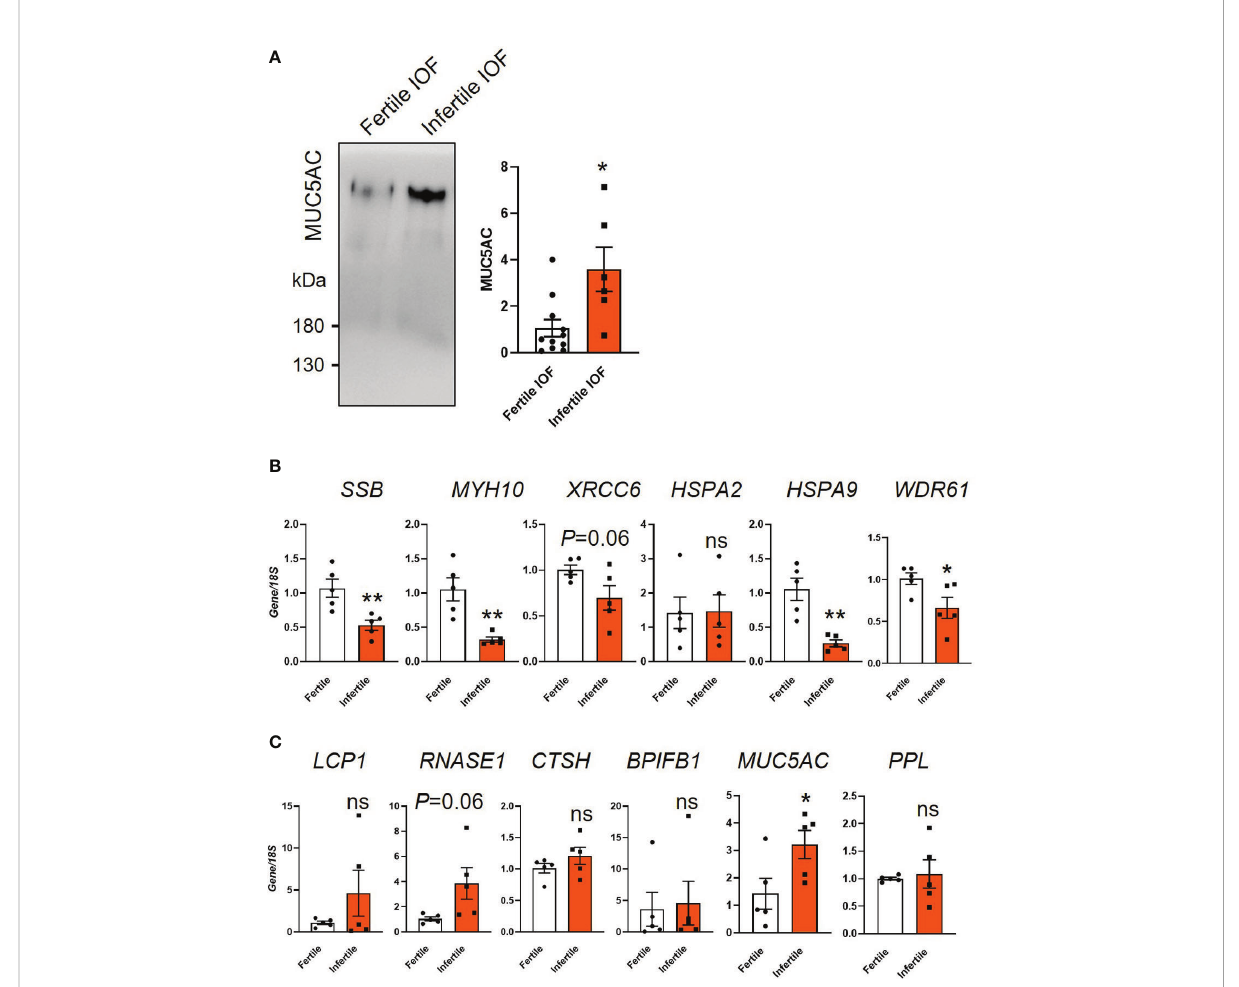
FIGURE 6 Examination of candidate proteins identi fi ed by mass spectrometry. (A) Immunoblot validation of MUC5AC expression in fertile and infertile IOF. Equal amounts of protein were loaded for examination (n=6-11 biological replicates). (B, C) qPCR examination of the production of candidate proteins in organoid cells. Top 6 signi fi cantly decreased (B) and increased (C) proteins ranked by fold change in infertile IOF compared to fertile IOF were selected for analysis. Gene expression levels were normalized to 18S (n=5 biological replicates). All data were presented as mean ± SEM. * P <0.05, ** P <0.01, ns, no signi fi cant difference; IOF, Intra-organoid fl